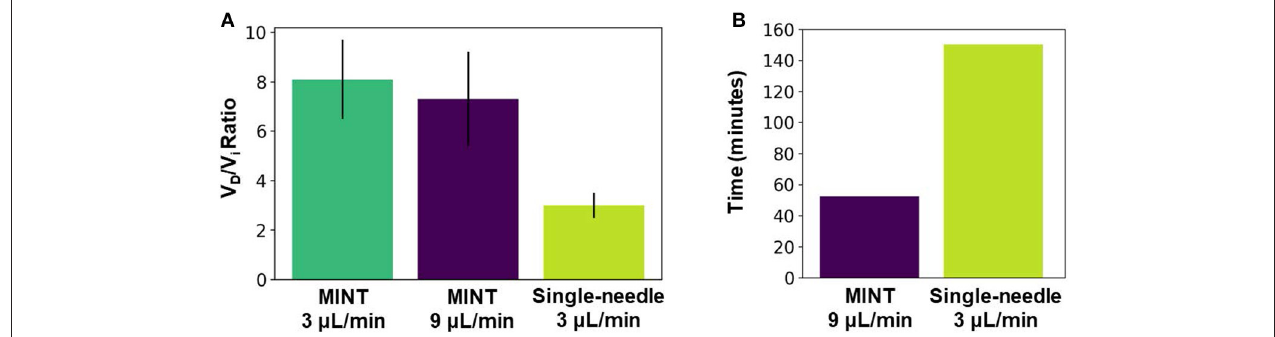
FIGURE 7 | (A) Average distribution ratio at V i = 450 µ L for MINT at 9 µ L/min total flow rate (i.e., 3 µ L/min per cannula) vs. single-needle CED at 3 µ L/min flow rate. (B) Infusion duration to reach V i = 450 uL for MINT at 9 µ L/min total flow rate (i.e., 3 µ L/min per cannula) vs. single-needle CED at 3 µ L/min flow rate. Error bars represent ± S.D. from n = 3 trials for multipoint at each flow rate condition and n = 4 trials for single-needle CED.